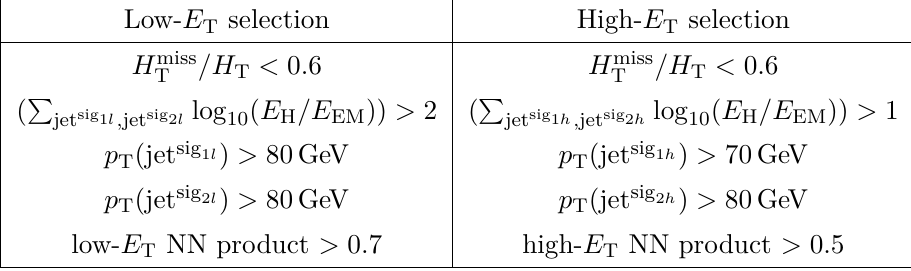
Table 2. Final selection requirements in the low- E T and high- E T